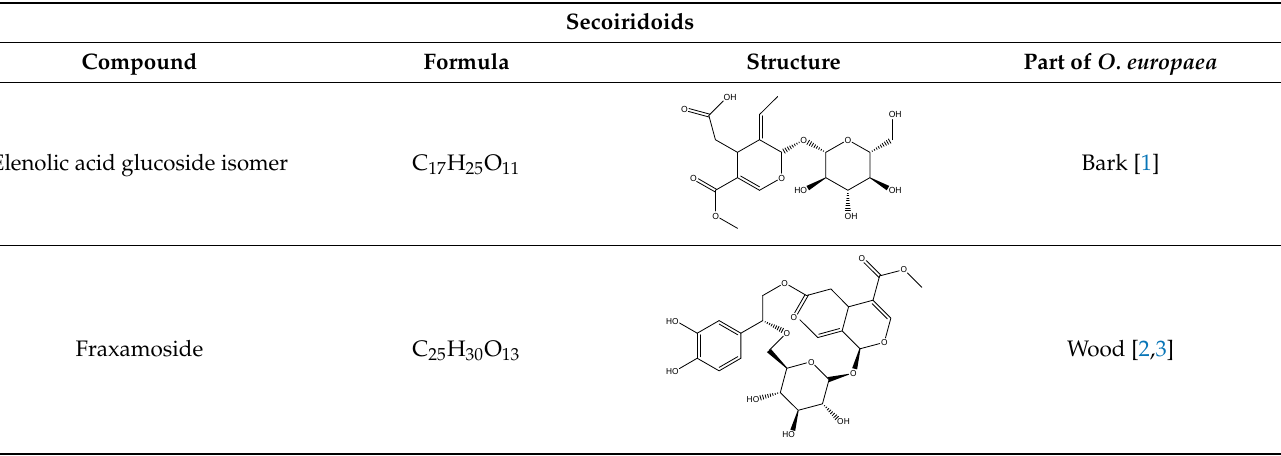
Table 1. Bioactive specialized metabolites identified in bark, root, wood, and pruning of O. europaea .